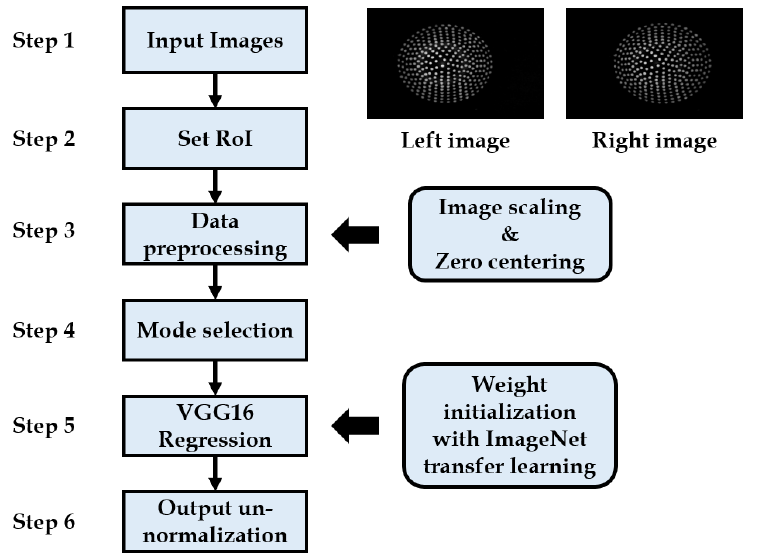
Figure 8. Flowchart schematic of transfer learning applied on the images acquired from tactile stereo camera setup.